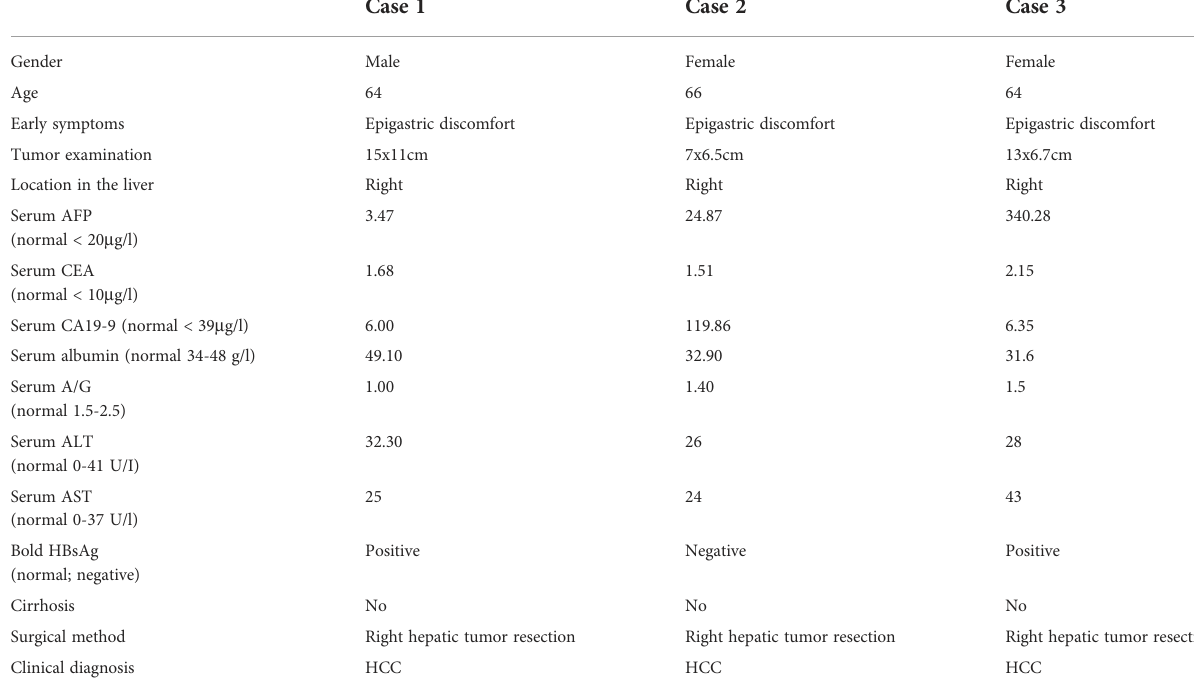
TABLE 1 Clinical characteristics of the three patients with HCS.